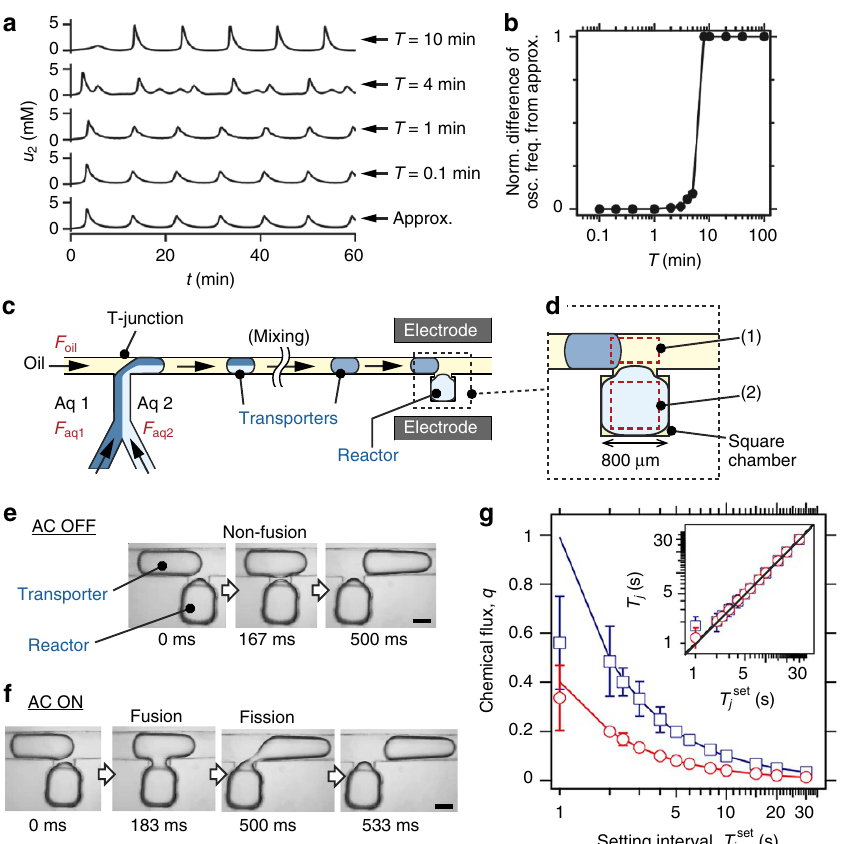
Figure 2 | Characterization of the droplet open-reactor system. ( a ) Results of numerical simulations of the autocatalytic reaction shown by equation (2) in the droplet open-reactor system. The simulations were performed using the general form indicated by equation (1) for T ¼ 0.1–10min, and using the approximate form described in equation (6) for ‘approx.’ (details are given in the Methods section). T j ¼ T and w j ¼ w for all j . w / T ¼ 0.25 (fixed), which results in oscillation. ( b ) Normalized (Norm.) difference of the oscillation (osc.) frequency (freq.) from ‘approx.’ in a . The value 0 indicates no frequency shift, whereas 1 means that the oscillation frequency is equivalent to the frequency of the fusion 1/ T . Details are given in the Methods section. The solid line is provided as a guide for the eyes. ( c ) Design overview of the microfluidic system (details are given in Supplementary Fig. 2). Channel height, 500 m m. F oil , flow rate of the oil phase; F aq1 and F aq2 , flow rate of the aqueous phases 1 and 2. ( d ) Enlarged view of the transporter and the reactor. The boxes outlined in red dashed lines indicate the areas in which (1) the detection of the transporter and (2) the fluorescence observation of the reactor were performed. ( e , f ) Bright-field microscope images of a fusion and fission event of a transporter and the reactor without and with a.c. voltage, respectively. Scale bars, 500 m m. ( g ) Control of q by T j set . Inset: control of T j by T j set . The blue, red and black solid lines represent ideal values. Error bars: s.d. Sample size: 30 measurements. transporter and reactor were water for e and f , and 0.1-mM Fl–Na for g